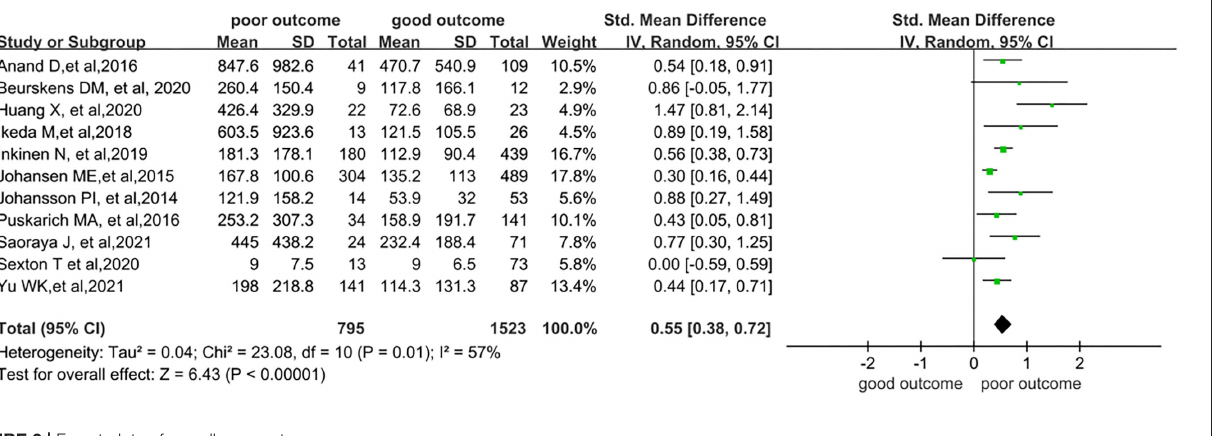
FIGURE 2 | Forest plots of overall poor